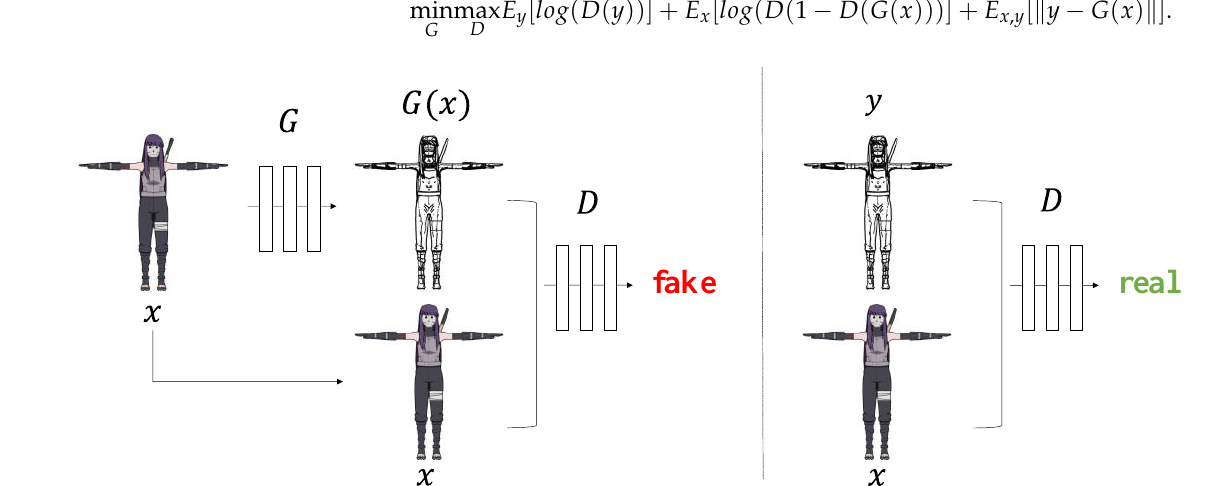
Figure 10. Conditional GAN training for line drawing extraction from 2D cartoon images.